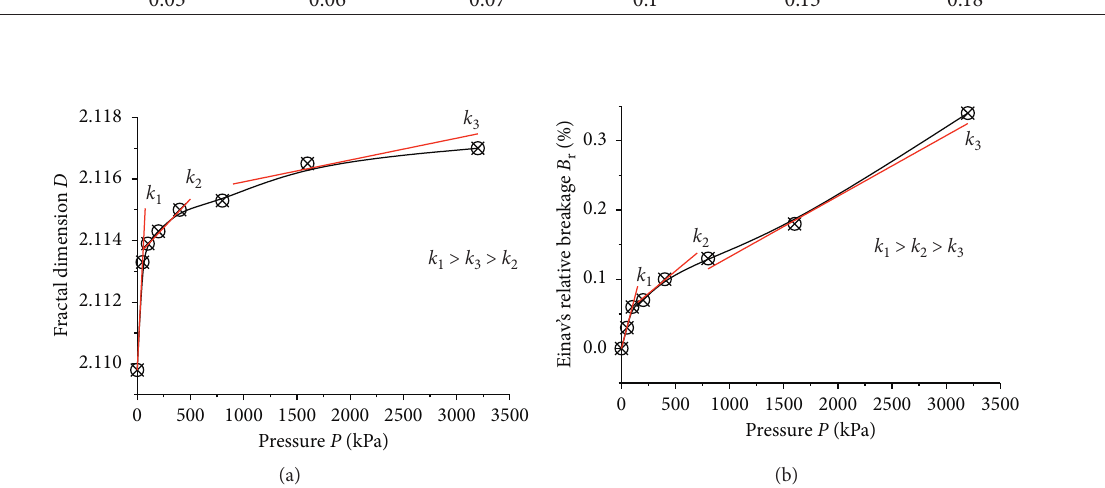
Figure 9: Relationship between breaking indexes and vertical stress (P): (a) fractal dimension (D); (b) Einav’s relative breakage.